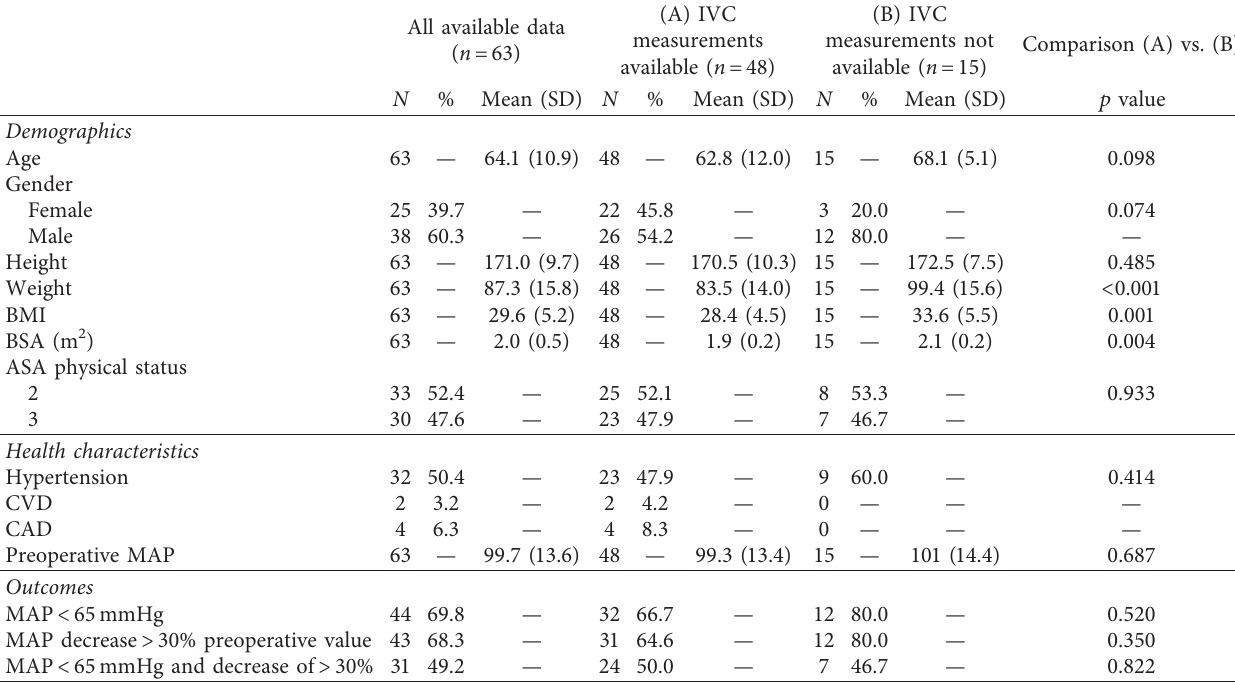
Table 2: Patient characteristics for all subjects and by the ability to obtain IVC measurements. All available